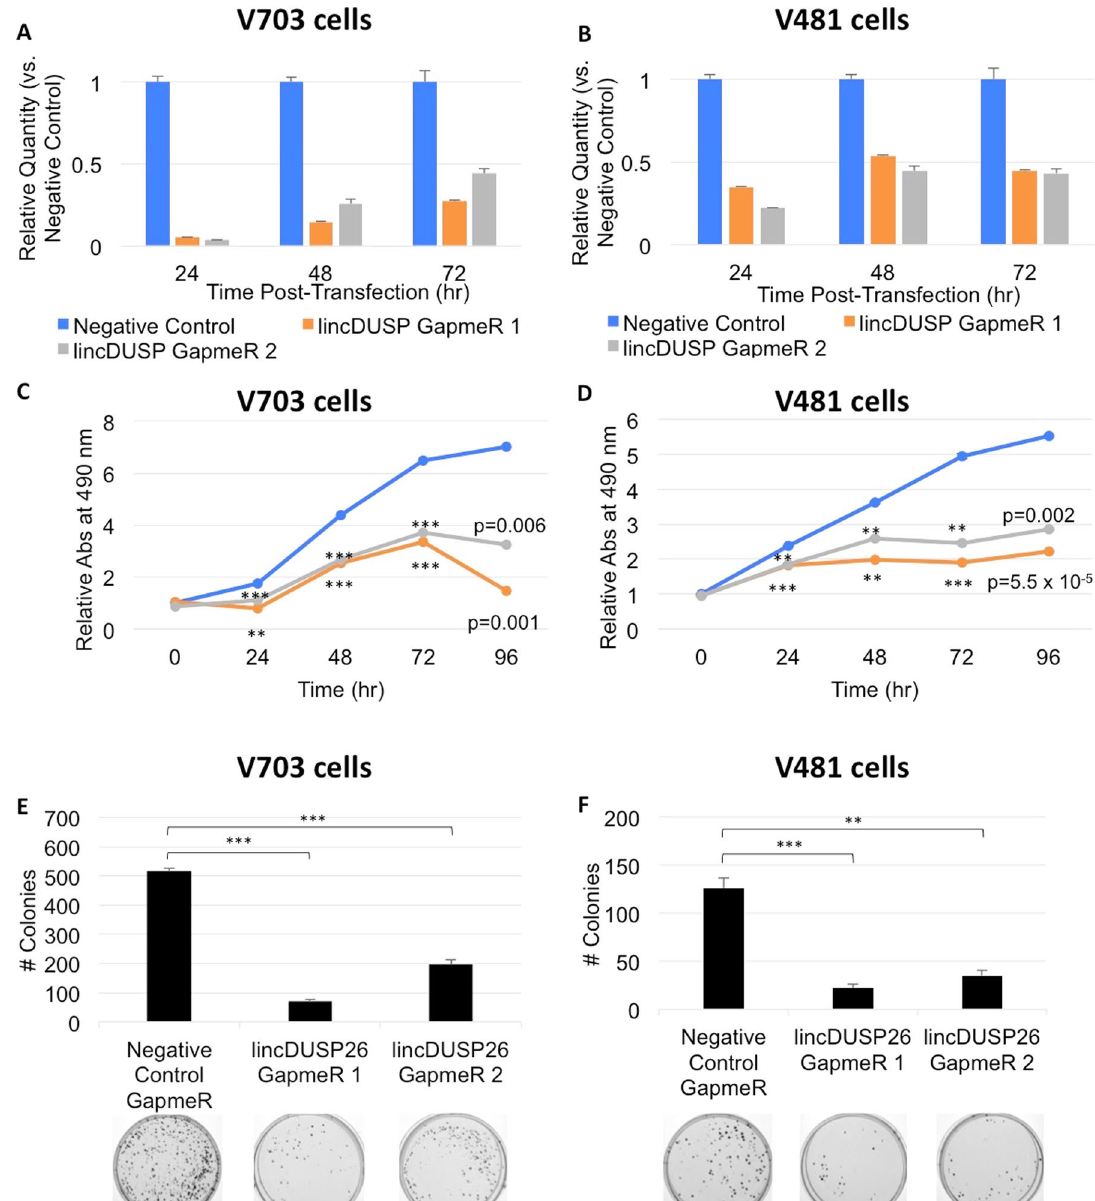
Figure 2. Knockdown of lincDUSP reduces proliferation and colony formation in vitro . ( A , B ) Verification of lincDUSP knockdown in V703 and V481 cells by LNA GapmeRs at 24, 48, and 72 hours. Error bars = SD (n = 2). ( C , D ) Proliferation assay in V703 and V481 cells treated with control GapmeRs vs. lincDUSP GapmeRs. The knockdown of lincDUSP significantly affects cell proliferations as compared to control cells. ( E , F ) Colony formation assay in V703 and V481 cells treated with control GapmeRs vs. lincDUSP GapmeRs. The depletion of lincDUSP has significant effects on the clonogenic capacity of colon cancer cells. Representative images shown below graph. Asterisks denote significant difference vs. negative control GapmeR by two-tailed t-test. ** < 0.05; *** <